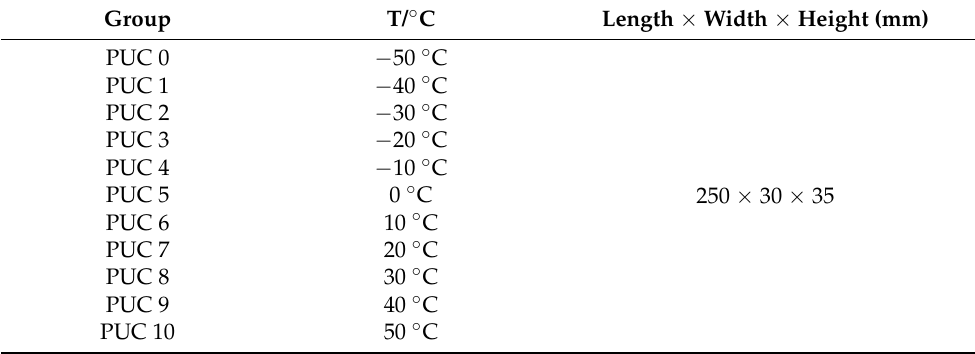
Table 7. Bending test protocol for polyurethane cement specimens at different temperatures.